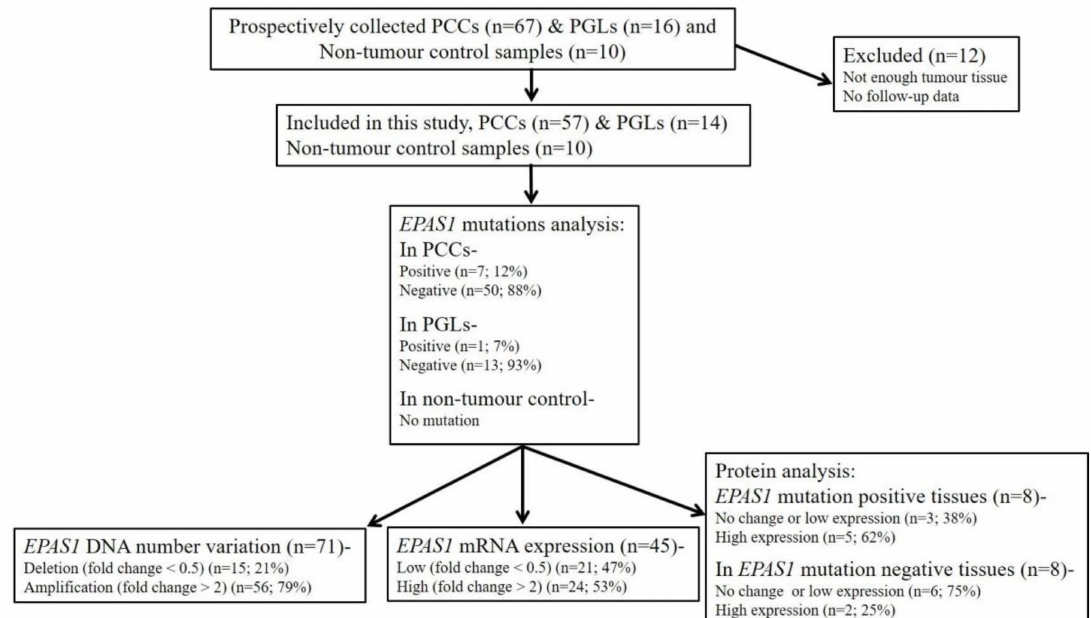
Figure 1. Schematic illustration of the methodological flow used for clinical samples analysis in the present study. PCCs: Phaeochromocytomas; PGLs: